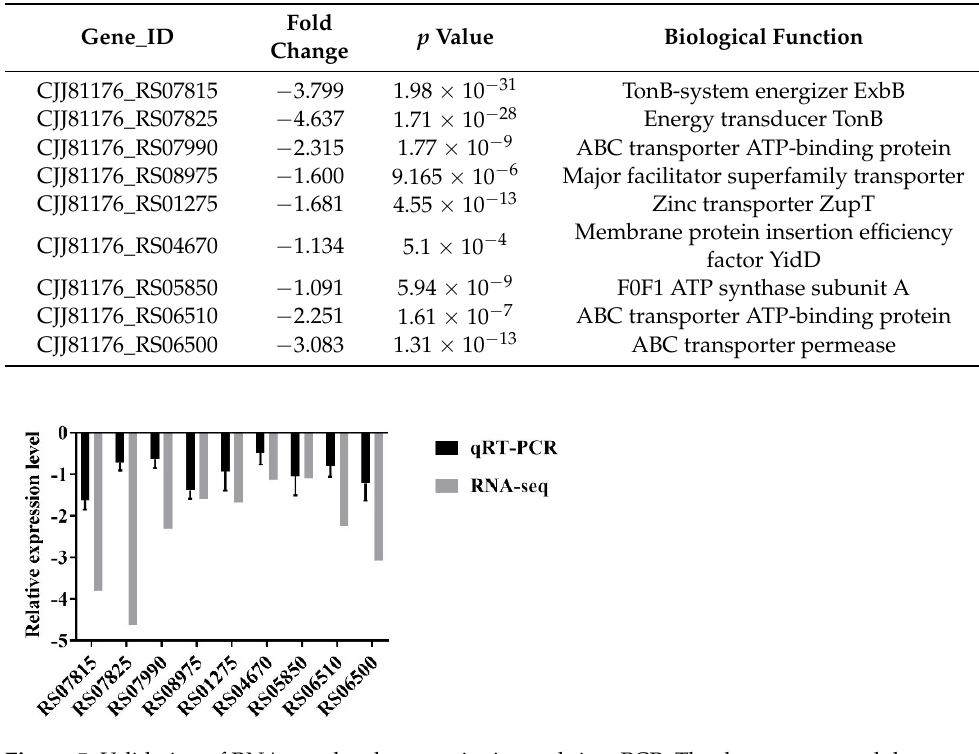
Figure 5. Validation of RNA-seq data by quantitative real-time PCR. The data represented the means ± standard deviation. Table 2. Transcription intensity changes of open reading frames of C. jejuni 81-176 treated with 16 Table 3. MICs of C. jejuni 81-176 mutants in μ g/mL DATS.